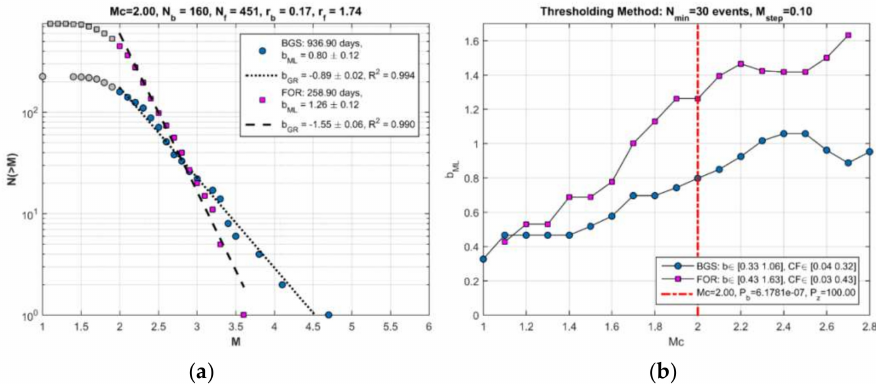
Figure 8. Time distribution of earthquakes (for M c ≥ 2.0 number of events N = 611 out of 975 totally listed in NOA catalogue) occurring during the background seismicity state (BGS 1, 1 January 2014–1 August 2016, number of events N b ) and the hypothetical foreshock activity (FOR-cluster 1, grey-shaded area, 1 August 2016–1 May 2017, number of events N f ). Cluster 1 is composed of three sequential sub-clusters. Plot in blue is the cumulative number of events versus time. Seismicity testing showed that cluster 1 has not been a foreshock sequence but a transient swarm activity (see Section 3.2.1). The plot in grey area is zoomed from 1 March 2016.